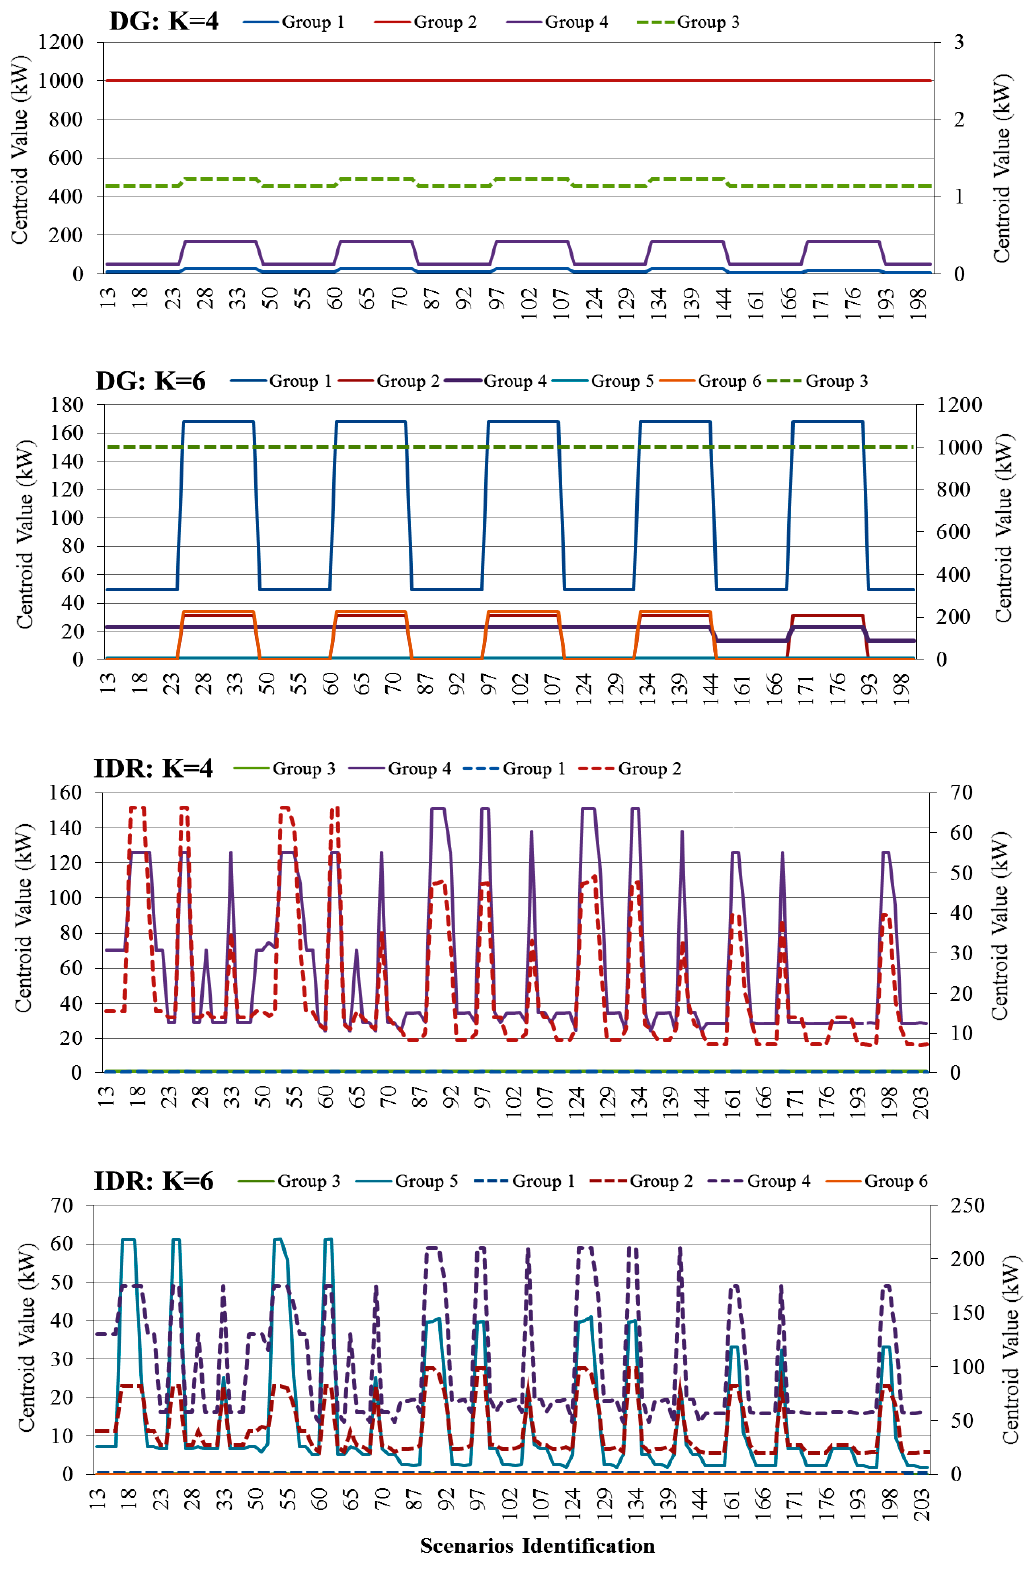
Figure 4. Centroid values of DG and IDR for a total number of clusters of K = 4 and K = 6. Figure 5. Centroid values of DG and IDR for a total number of clusters of K = 4 and K =